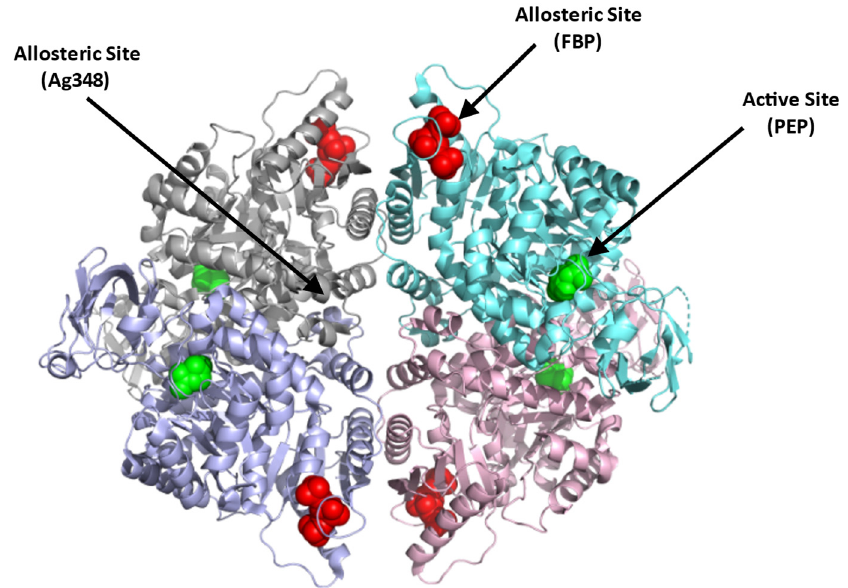
Figure 4. Crystal structure of PKR (PDB:2VGB) showing the allosteric site with FBP bound (red sphere), dimer–dimer interface binding site where the synthetic AG-348 is known to bind, and the active site with bound PEP (green sphere). The four subunits are shown in ribbons and colored gray, cyan, purple, and pink.